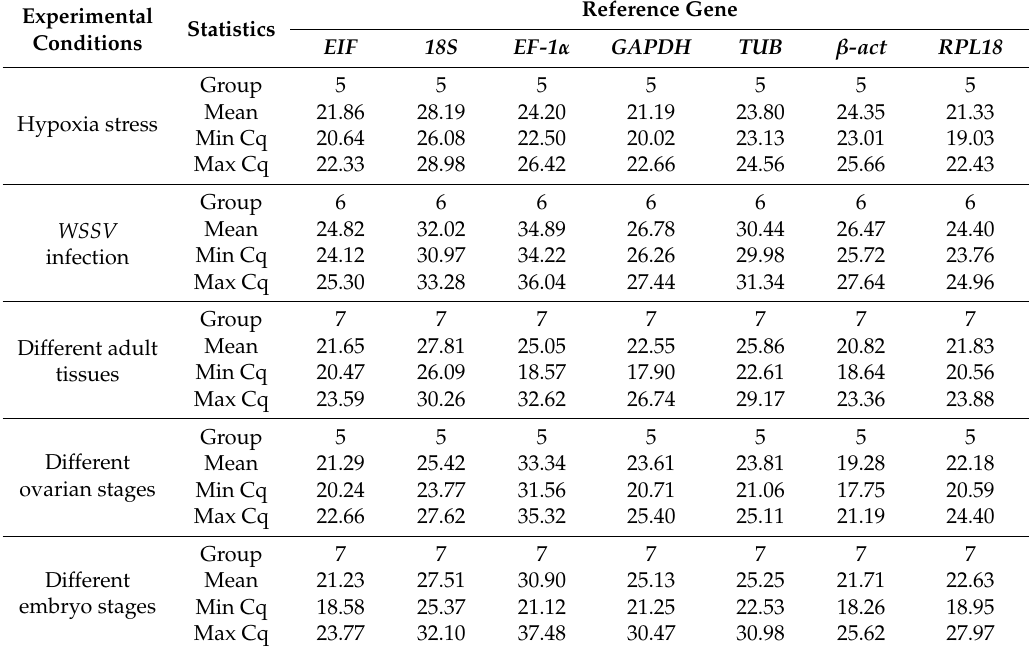
Table 2. Detailed distribution of cycle threshold (Cq) value information.